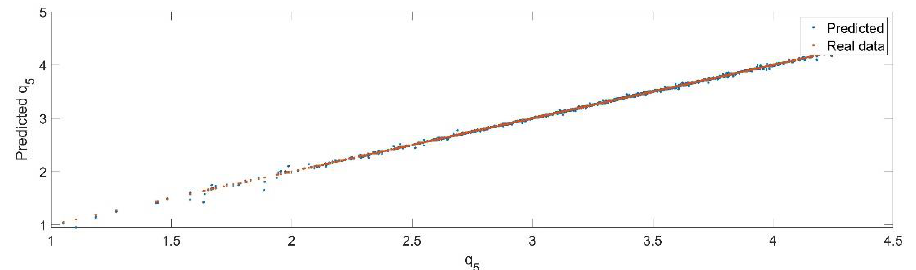
Figure 24. The comparison between the real data (the real value of 𝑞 5 ) and the predicted data (the predicted value of 𝑞 5 ).